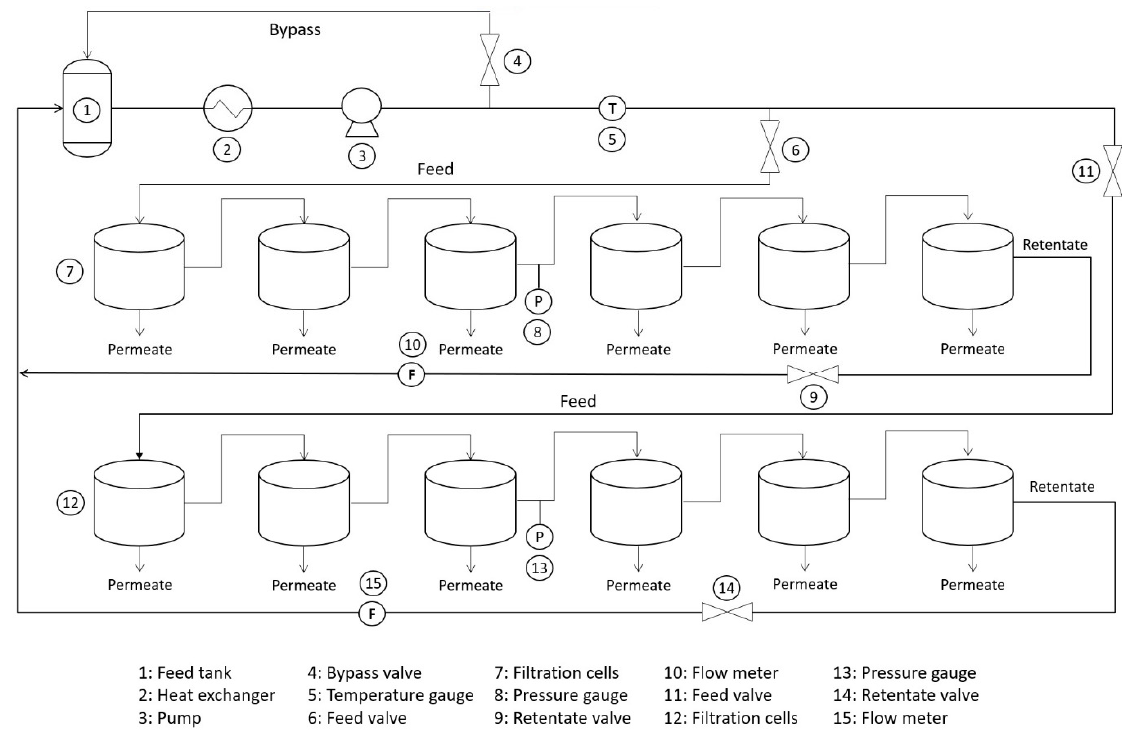
Figure 4. NF membrane coupons tester set-up. Figure 5. Rejection of MgSO 4 for membranes A ( a ), B ( b ), and C ( c ) at standard conditions before and after the permeation of black